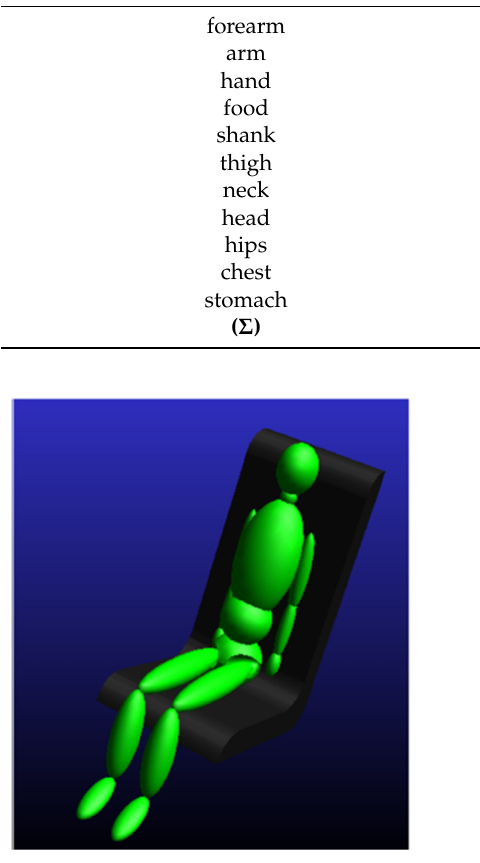
Figure 3. Anthropometric dummy for crash tests made in ADAMS